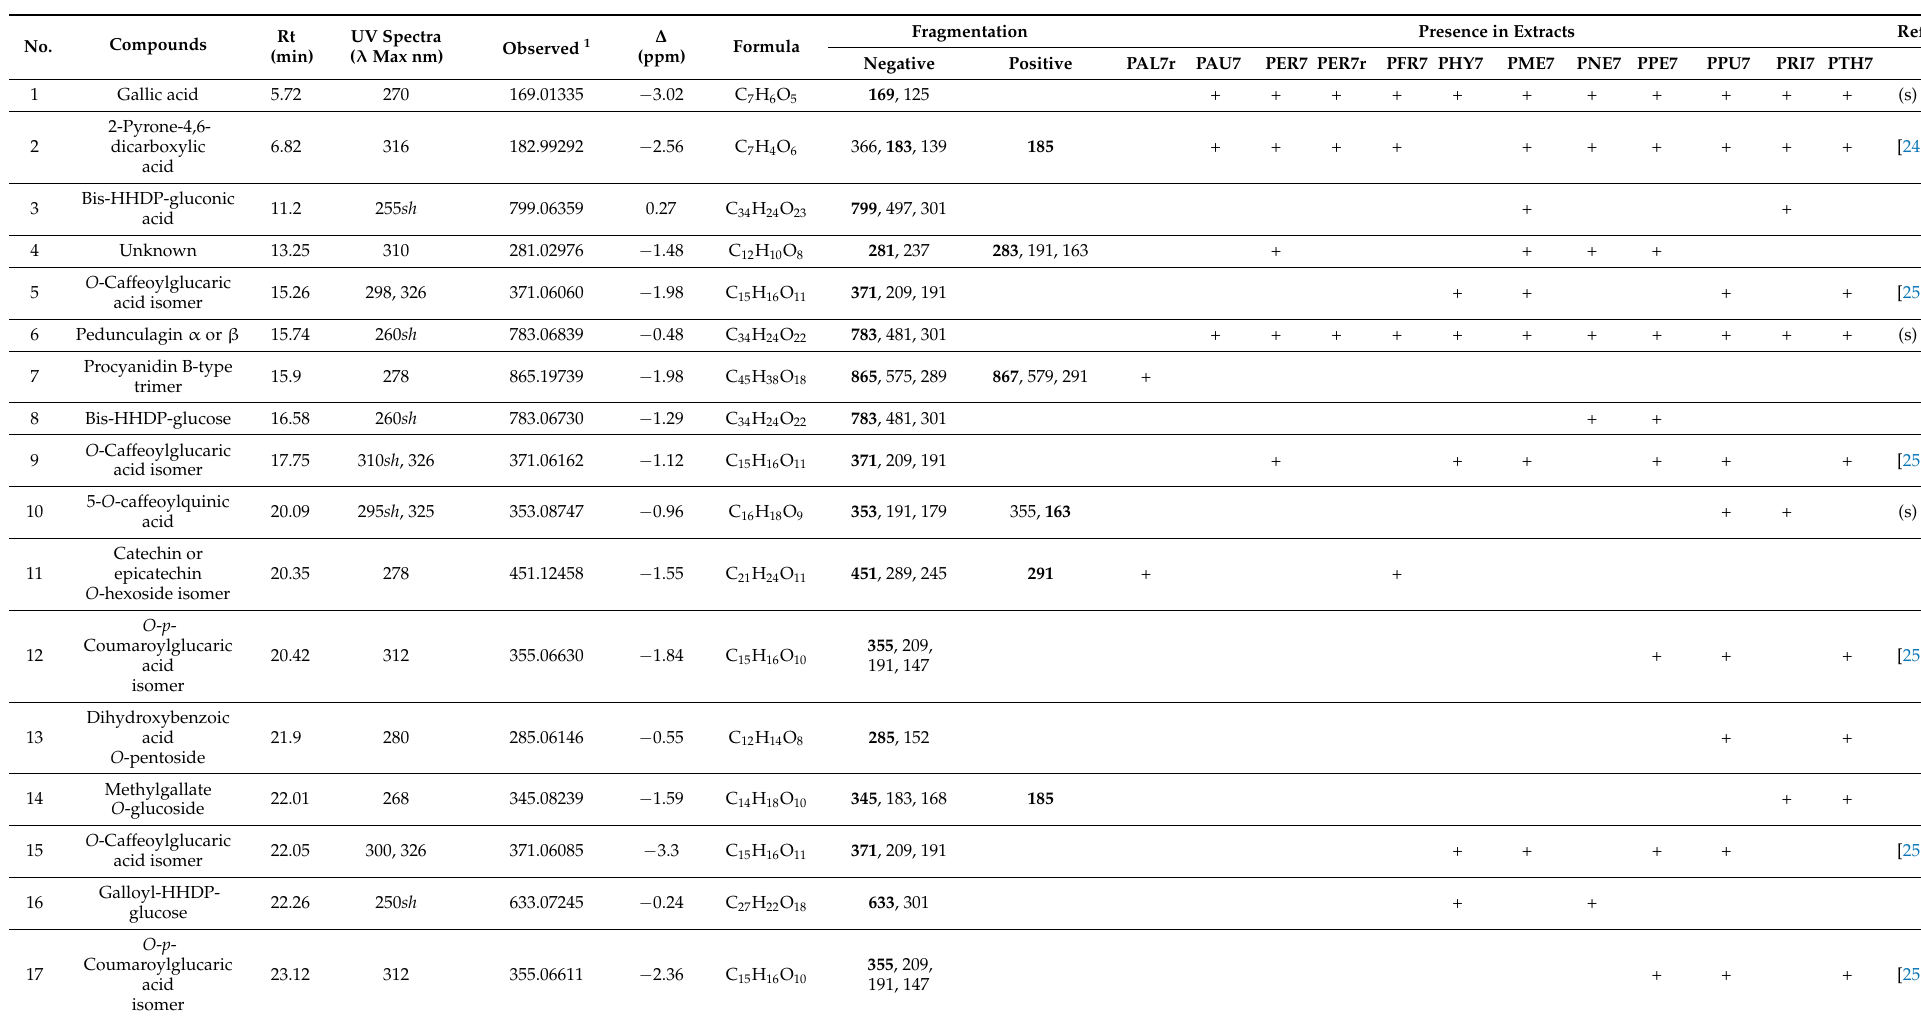
Table 2. LC–HRMS qualitative analysis of aqueous acetone extracts from aerial and underground parts of selected Potentilla